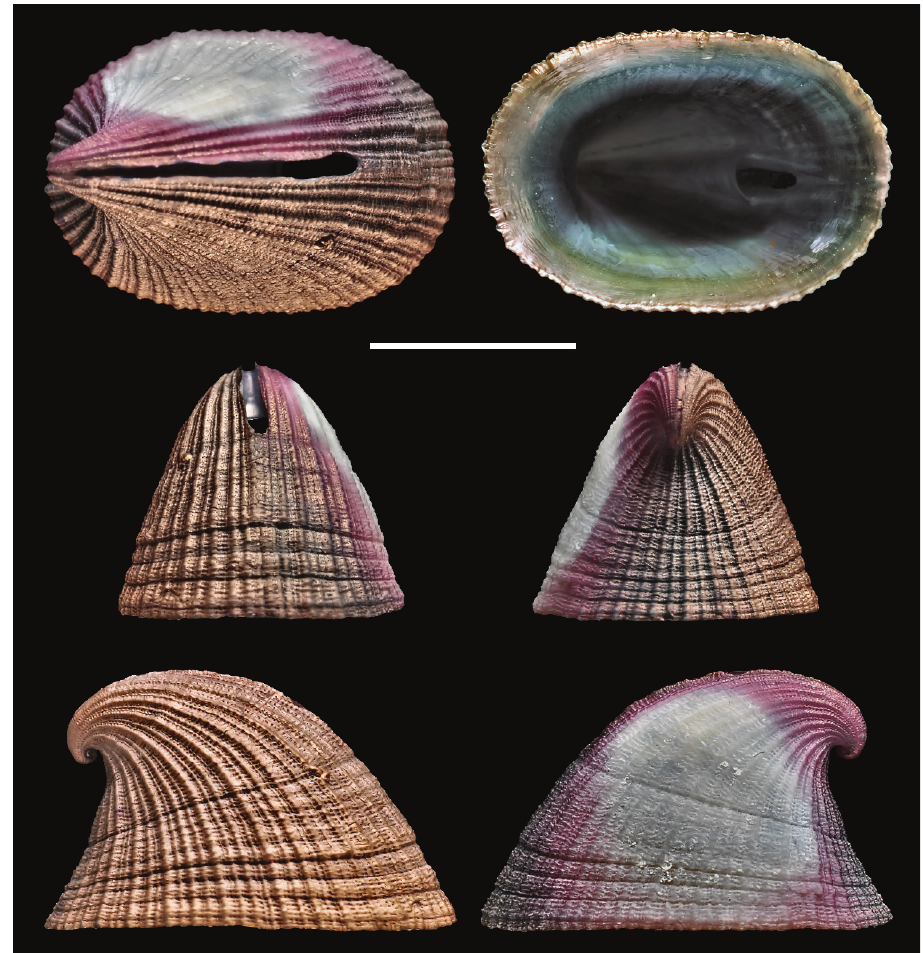
Figure 14. Puncturella ( Granopsis ) serraticosta Herbert & Kilburn, 1986. Holotype T3013/NMSA-MOL 0C7064. Scale bar: 5